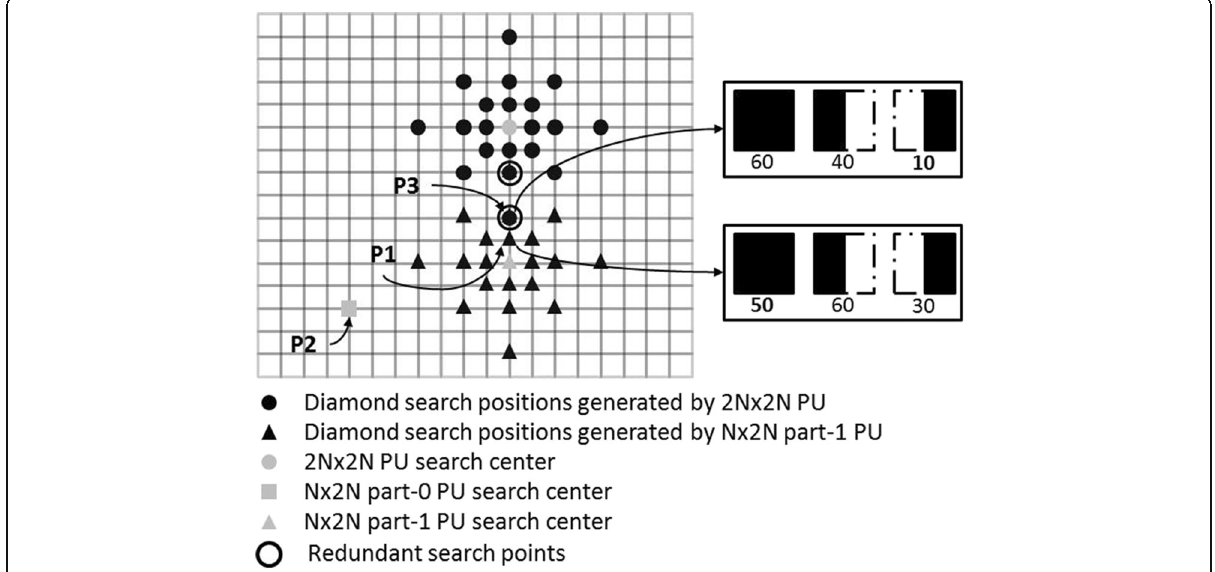
Fig. 7 The first iteration of the refinement